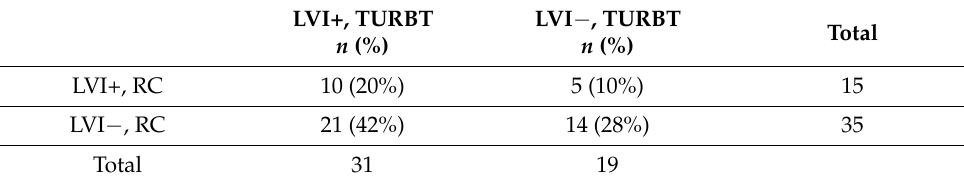
Table 4. Concordance between LVI at first TURBT and RC.